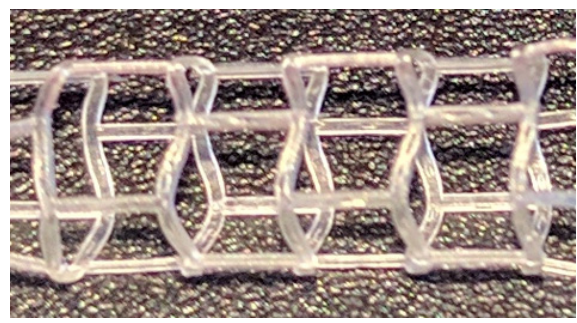
Figure 14. Model fabricated by microinjection moulding .